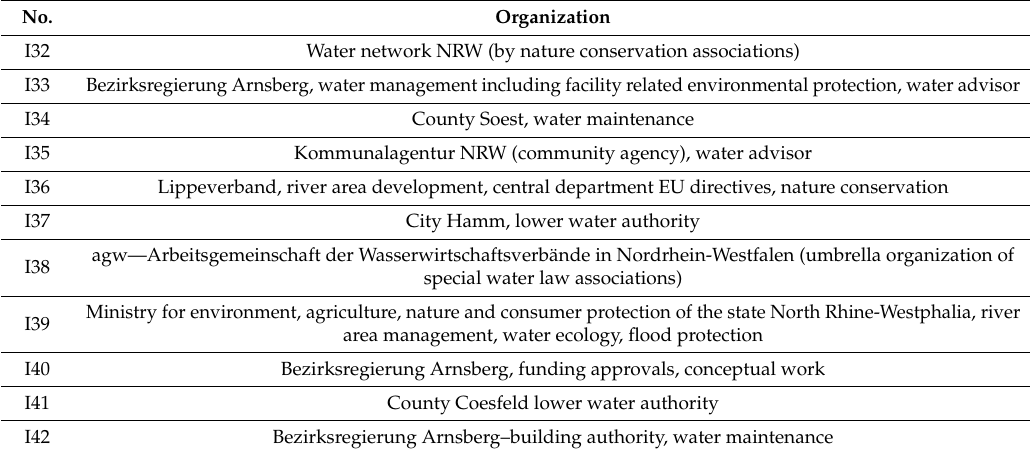
Table A4. NRW: October–December 2018, February 2019.